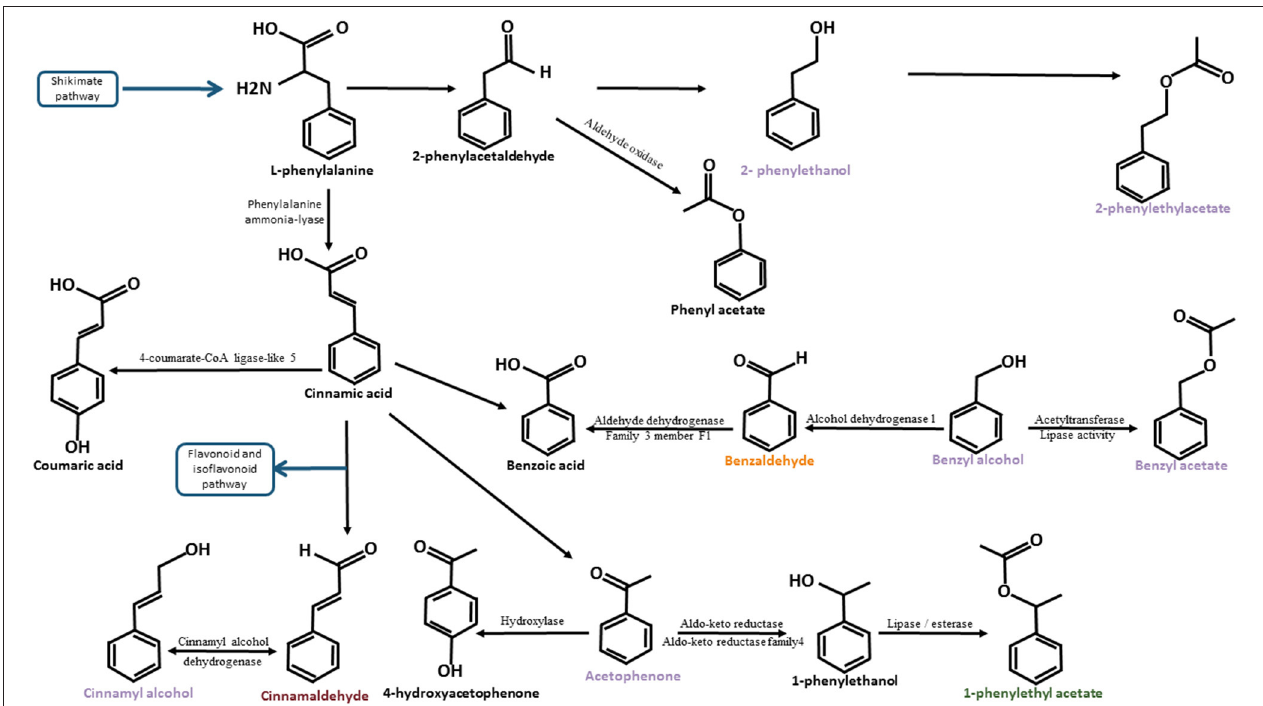
FIGURE 6 | Degradation pathway of L-phenylalanine adapted from Lapadatescu et al. (2000). The schema illustrates the different biosynthesis pathways of compounds belonging to the L-phenylalanine degradation pathway identified in cocoa. Compounds known to have a floral taste are noted in purple. Compounds known to have a fruity taste are noted in orange. Compounds known to have a spicy note are noted in dark red. The blue arrows represent the bridges between the L-phenylalanine degradation pathway and other biosynthetic pathways. The names of these other biosynthetic pathways are framed in blue. Black arrows represent the enzymatic actions. The names of the enzymes are indicated (when identified) around these